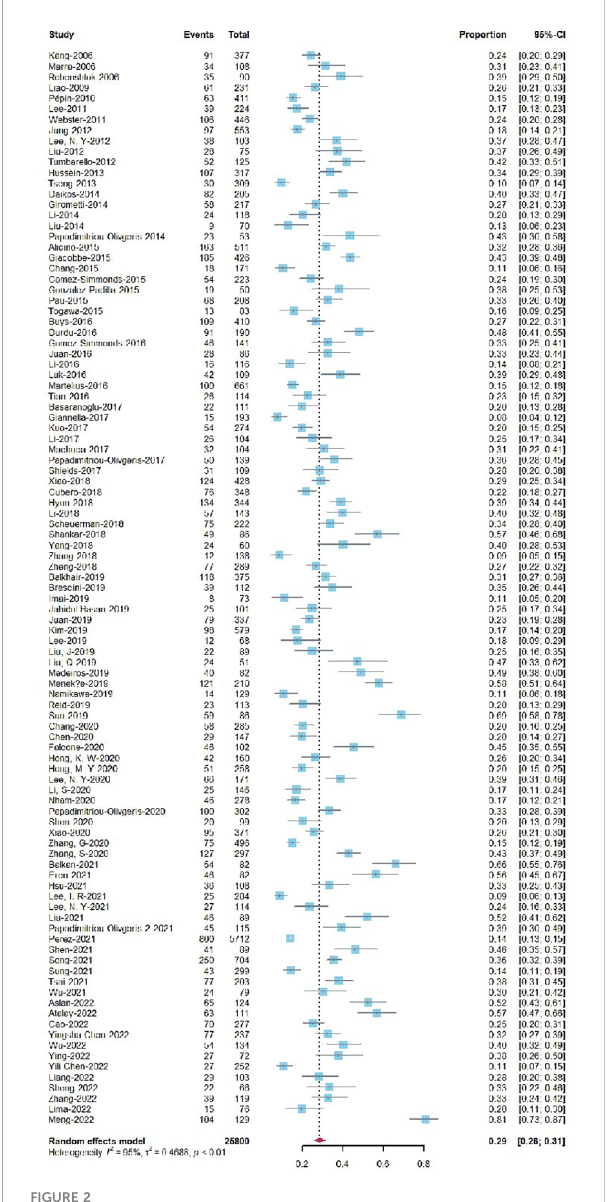
FIGURE 2 Forest plot of single proportion 30-day mortality for